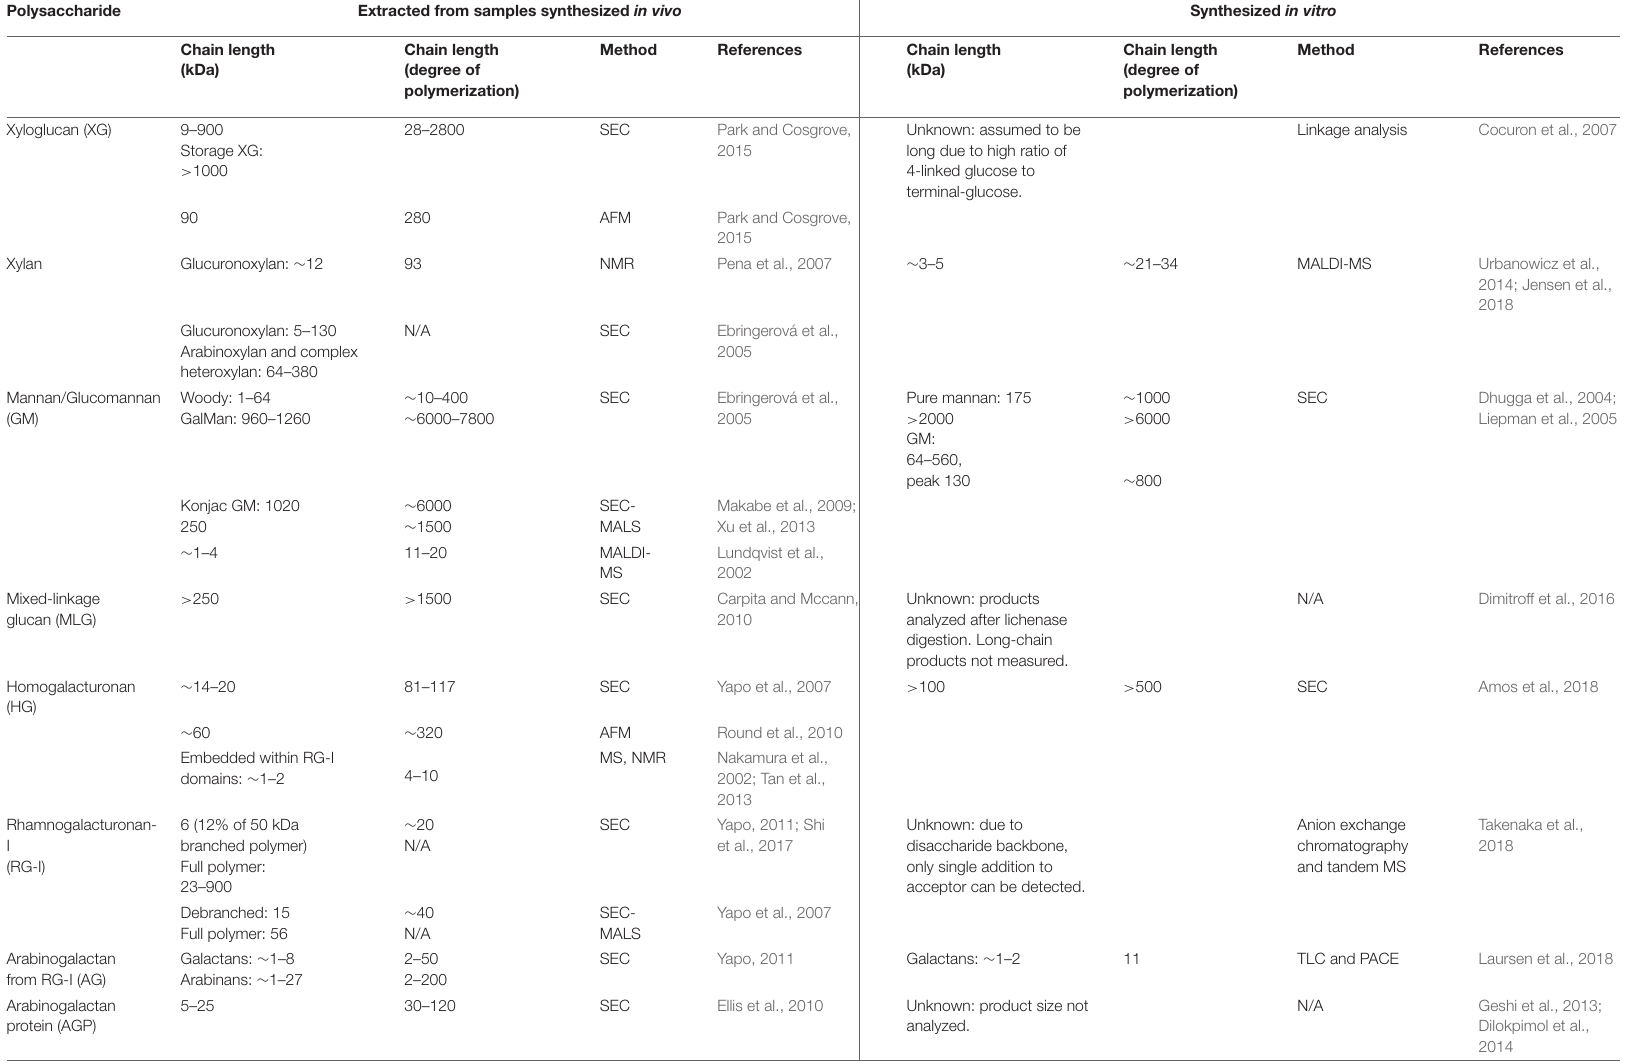
Chain length values (kDa and DP) are either stated directly in references, inferred from reported data, or are a range of figures compiled within reviews. If only the kDa or DP value was reported, the other value was estimated from the molecular weight of component monosaccharides. In some cases, the chain length in DP cannot be estimated due to large amounts of heterogeneity and side-chain branching, indicated by N/A. Use of a tilde ( ∼ ) indicates estimated values and use of a greater-than sign ( > ) indicates that high molecular weight polymers that elute near the void volume of a size exclusion column are unable to be precisely measured and the reported size is compared to a dextran standard. SEC, size exclusion chromatography; AFM, atomic force microscopy; MALS, multiangle light scattering; MS, mass spectrometry; MALDI, Matrix-assisted laser desorption/ionization; TLC, thin-layer chromatography; PACE, polysaccharide analysis using carbohydrate gel